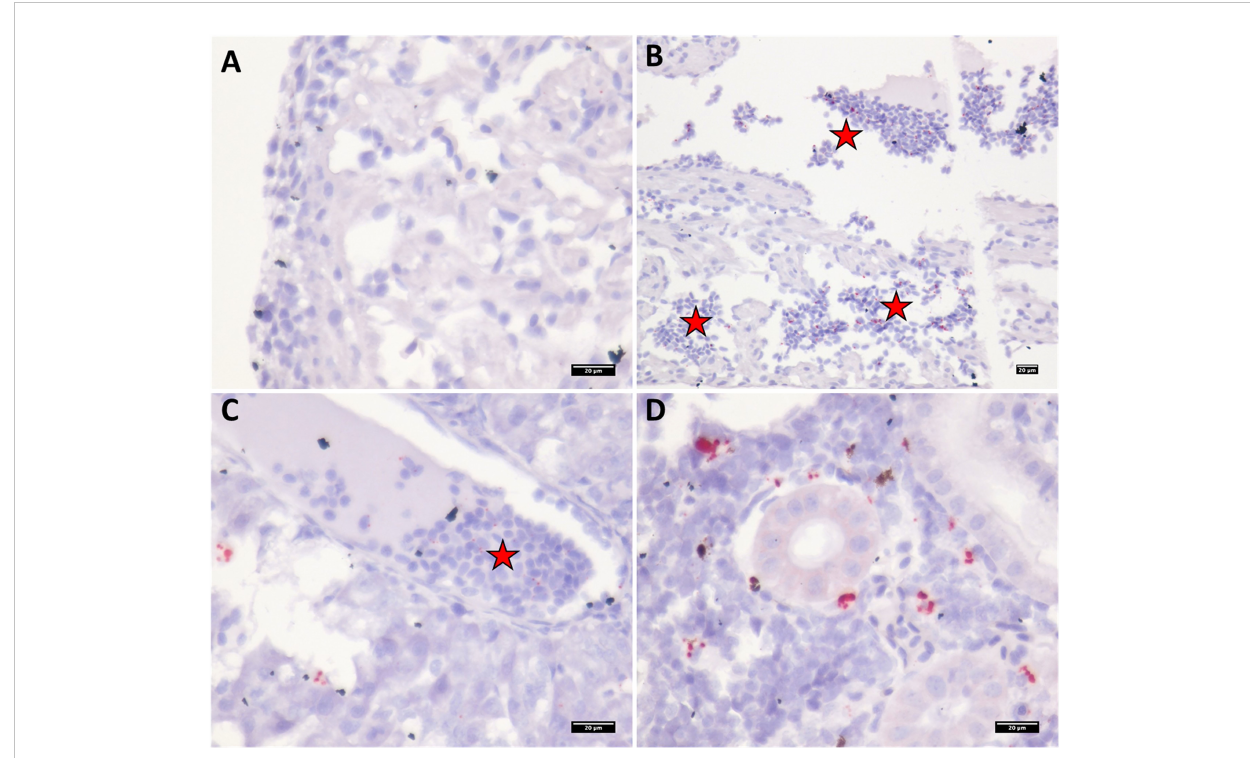
FIGURE 9 Micrographs showing PRV-1 in situ staining of bath challenged Atlantic salmon tissues at 12WPI. (A) no staining in epicardium or cardiomyocytes (B) PRV-1 positive staining in erythrocytes in heart ventricle (C) Liver showing positive staining in erythrocytes. (D) In kidney, PRV-1 staining is observed in erythrocytes and melanomacrophages. PRV-1 positive staining in erythrocytes in different organs highlighted in red